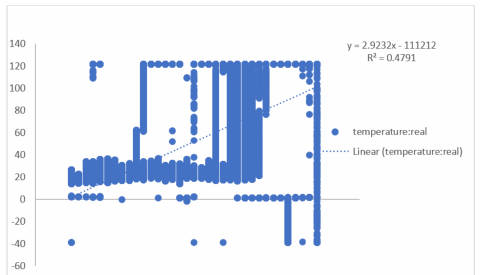
Figure 2. A representation of temperature data values over the sensed period.